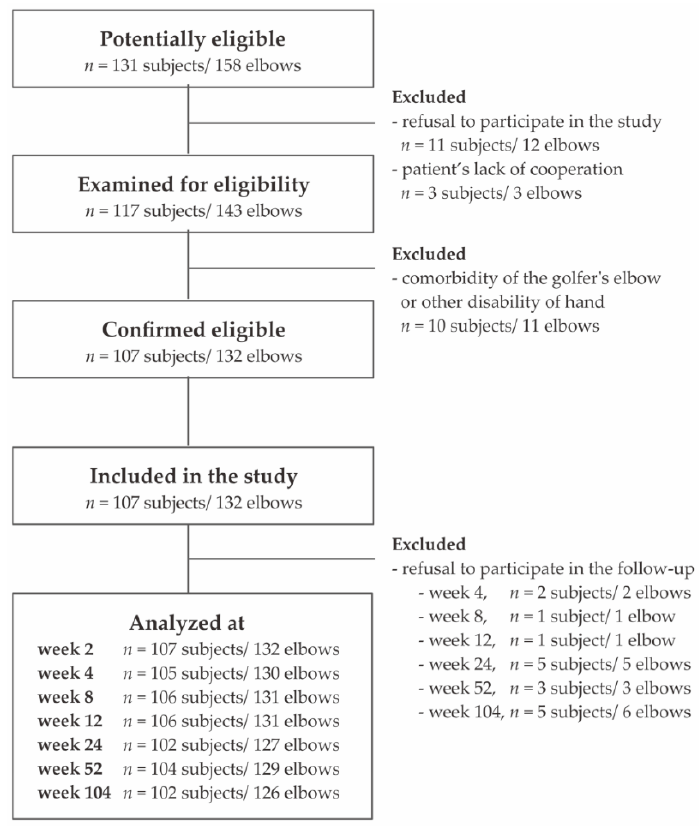
Figure 1. Flowchart of the study selection.